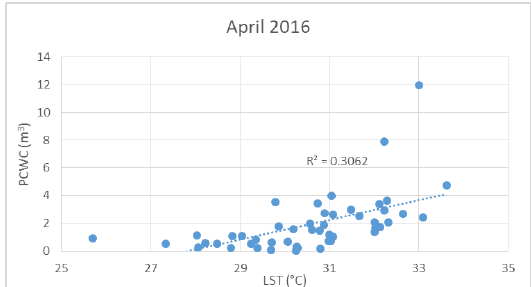
Figure 6. Correlation of LST and PCWC for the month of